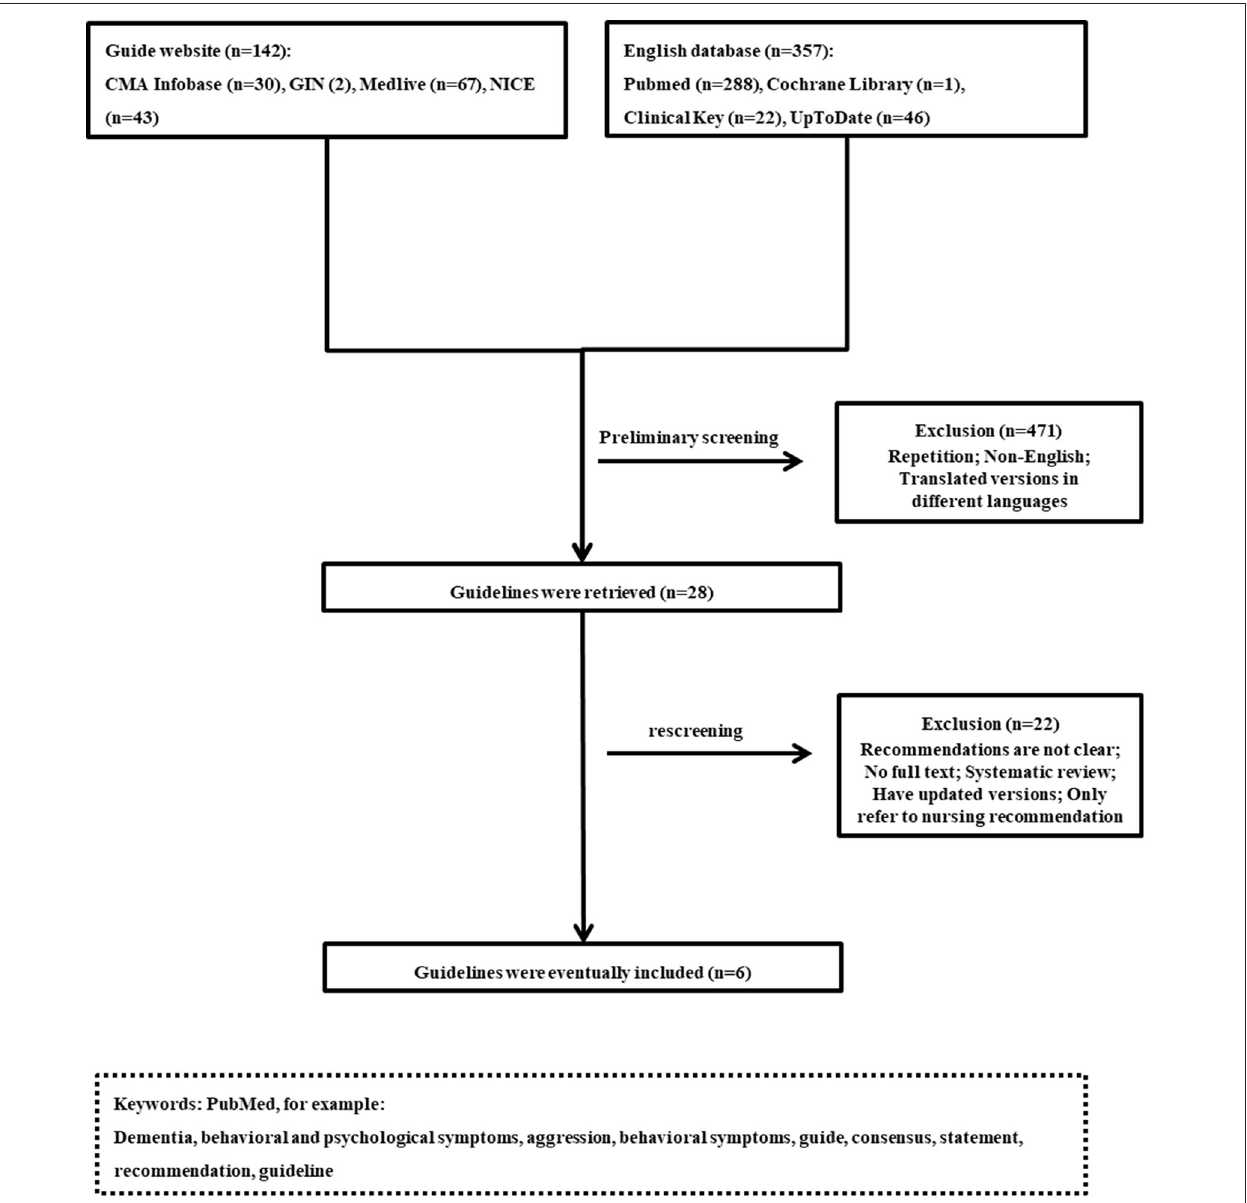
FIGURE 1 | The flowchart of the systematic search. (CMA Infobase), Canadian Medical Association Infobase; (GIN), Guidelines International Network; (NICE), National Institute for Health and Care